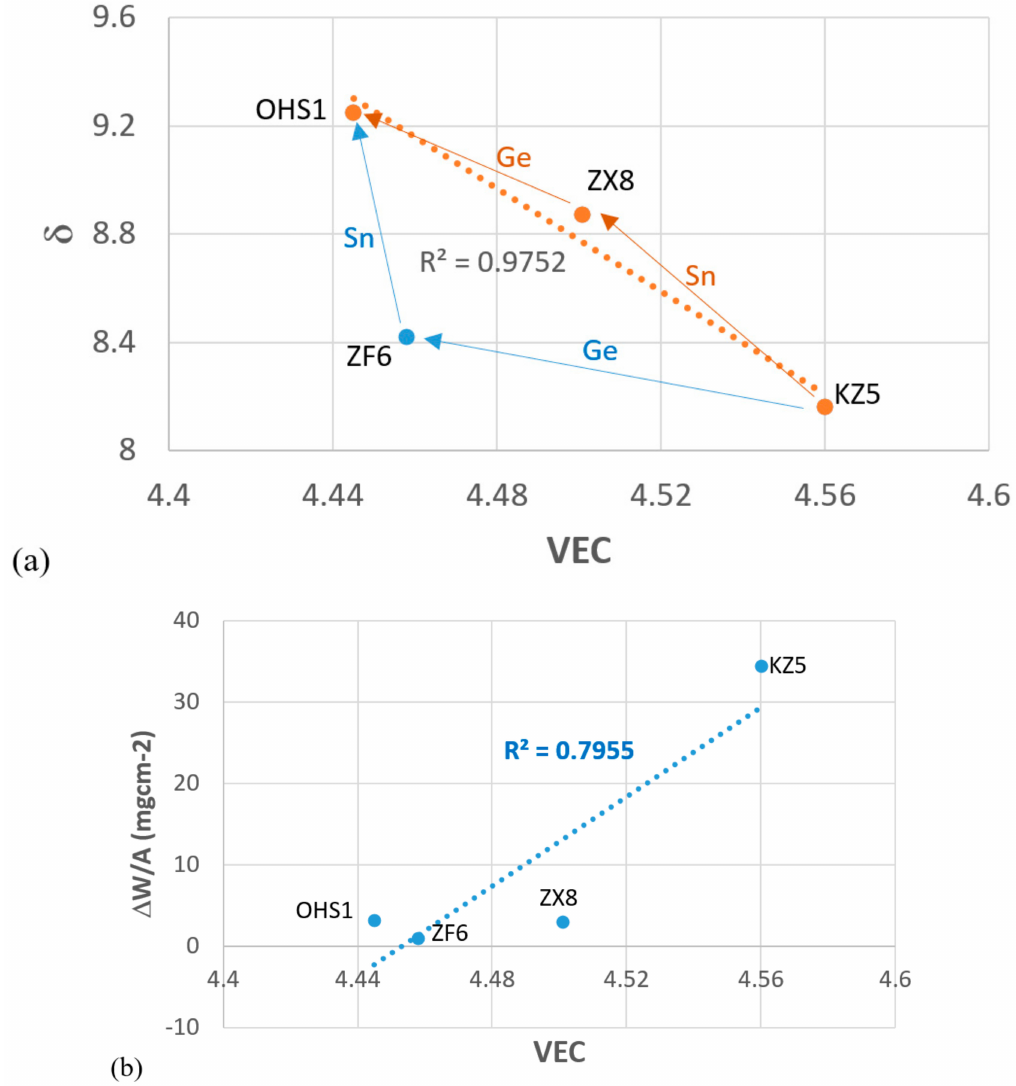
Figure 15. Plots ( a ) of the parameters δ and VEC and ( b ) of weight change per unit area at 800 ◦ C versus